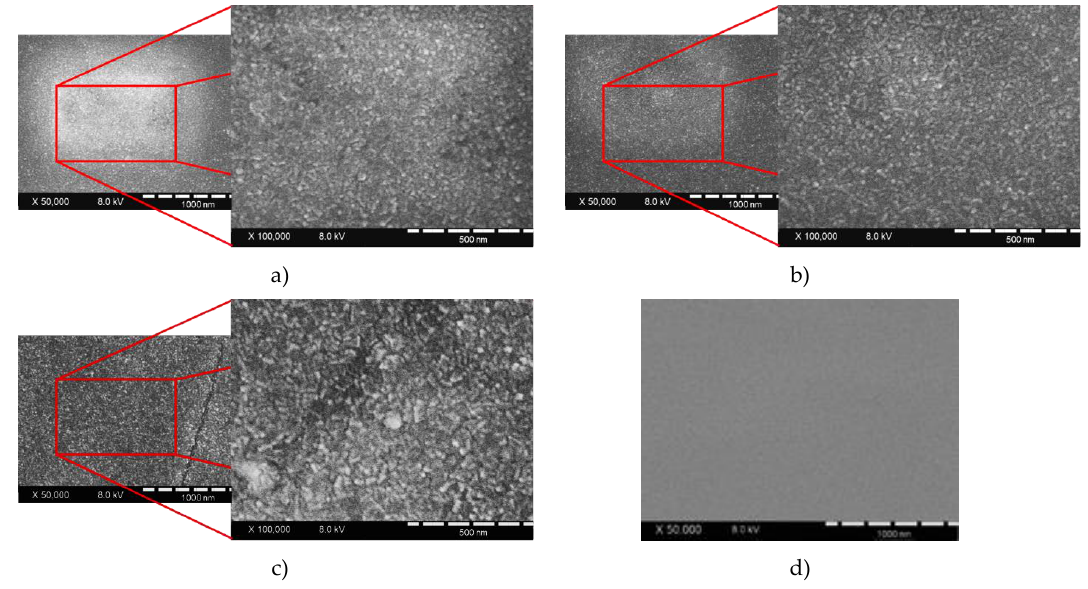
Figure 9. SEM pictures of ( a ) 0.9 wt % Mg/TiO 2 ; ( b ) 0.5 wt % Ni/TiO 2 ; ( c ) 0.6 wt % Cu/TiO 2 ; ( d ) TiO 2 thin films.